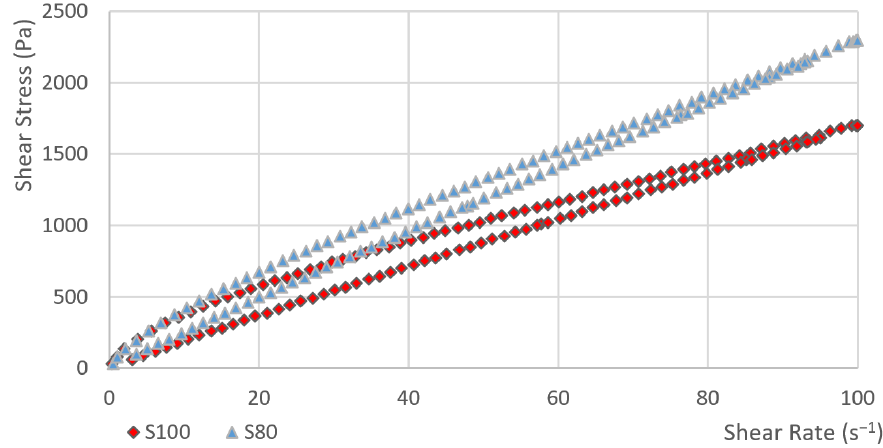
Figure 1. The dependence of the shear stress on the shear rate (sample: S80 and S100).